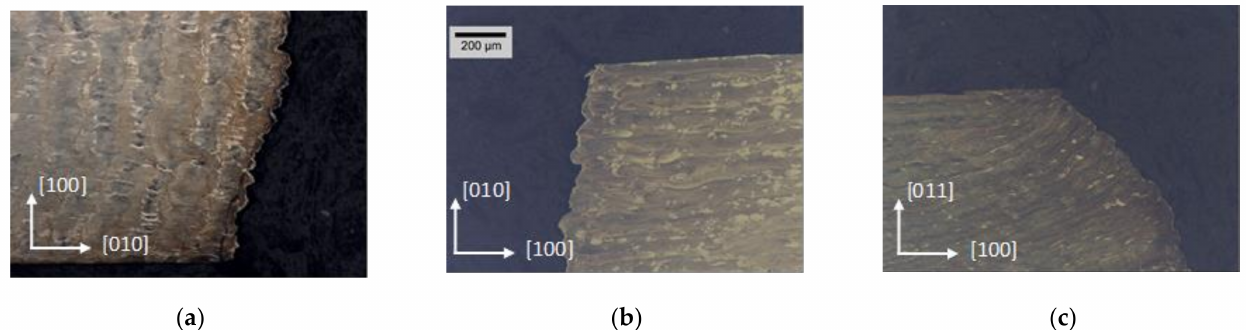
Figure 4. Rippled cylinders after compression ( a ) 0 ◦ –[010]–90 ◦ , ( b ) 0 ◦ –[100]–90 ◦ , and ( c ) 0 ◦ –[100]–0 ◦